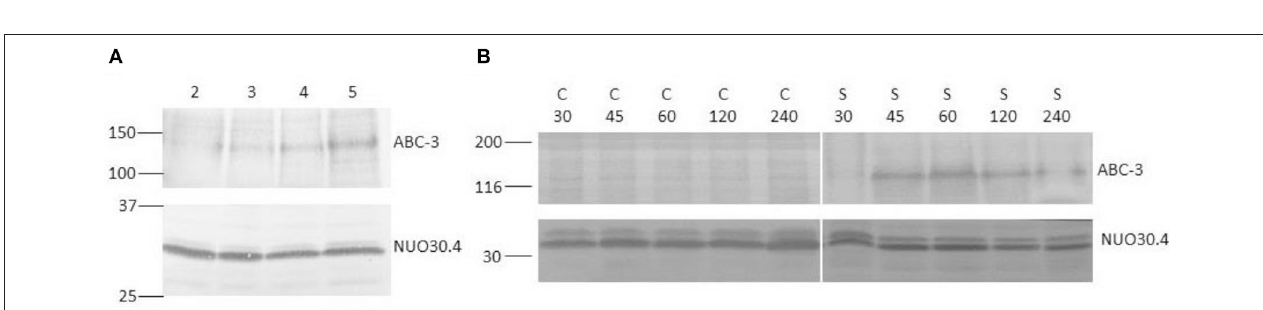
FIGURE 1 | STS does not interact with lipid bilayers: the intrinsic fluorescence properties of STS are similar in PBS and in the presence of different lipid phases. (A) steady-state fluorescence anisotropy; (B) amplitude-weighted (black bars) and intensity-weighted (white bars) mean fluorescence lifetime. The results represent the mean ± S. D. of at least three independent experiments, n ≥ 3.